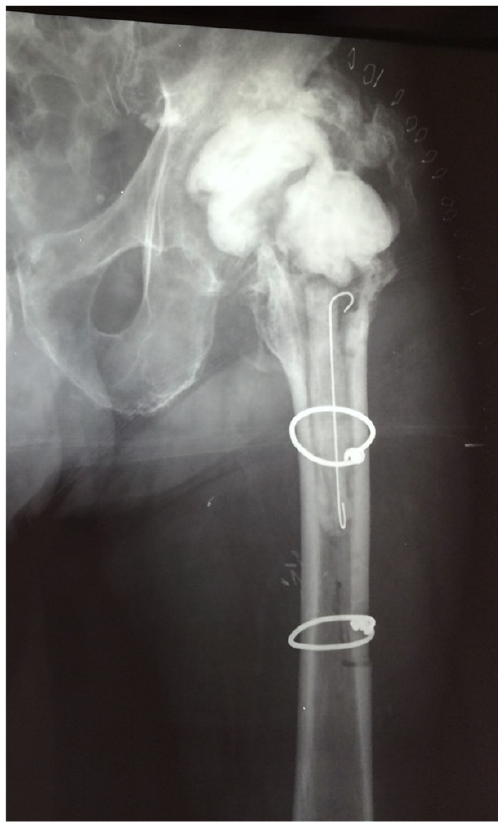
Figure 3: Postoperative anteroposterior radiograph after first stage revision shows the custom PMMA spacer that was fashioned and placed in the femoral lumen and the Paprosky osteotomy repair with cerclage wires.